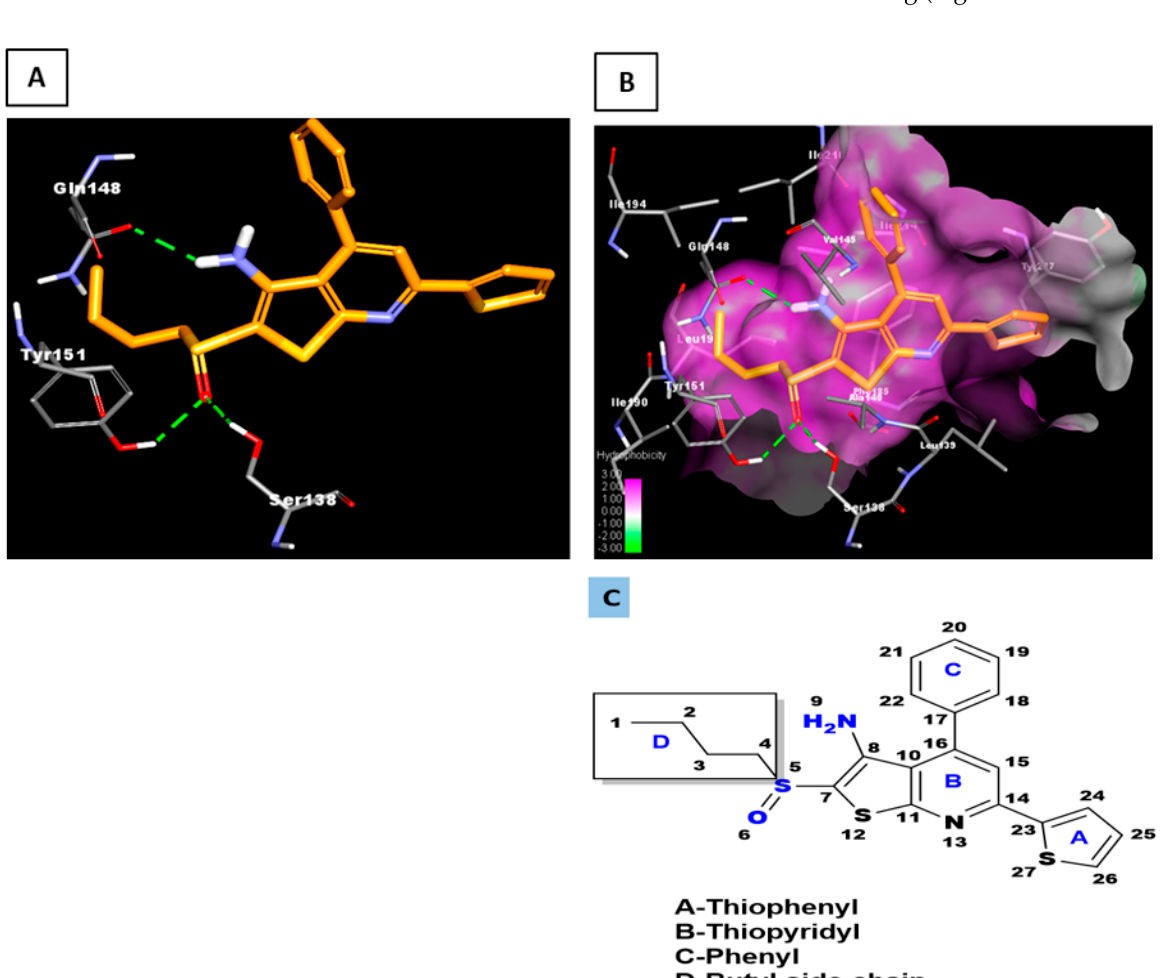
Figure 2. ( A ). Docked pose of ( R )-S(O)-SW033291 showing hydrogen-bond interactions with residues Ser138, Gln148, and Tyr151. ( R )-S(O)-SW033291 is colored gold while 15-PGDH is colored by atom. ( B ). Surface view of residues within 3.5 Ȧ of ( R )-S(O)-SW033291 docked pose revealing binding site residues are mostly hydrophobic in nature. The hydrophobic binding surface is represented using the scale in the lower left hand corner of the figure. ( C ). ( R )-S(O)-SW033291 showing atom numbering. Crucial pharmacophore features contributing towards activity are highlighted in blue.